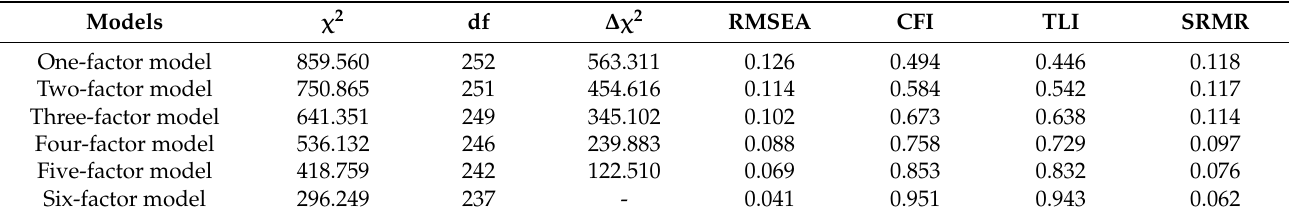
Table 3. Competitive measurement model comparison.